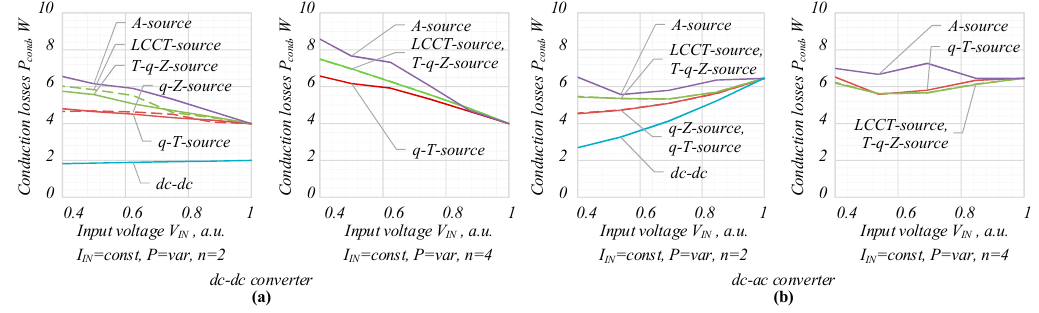
Figure 7. Conduction losses by di ff erent ( n ) in ( a ) the dc-dc converter and ( b ) the inverter.